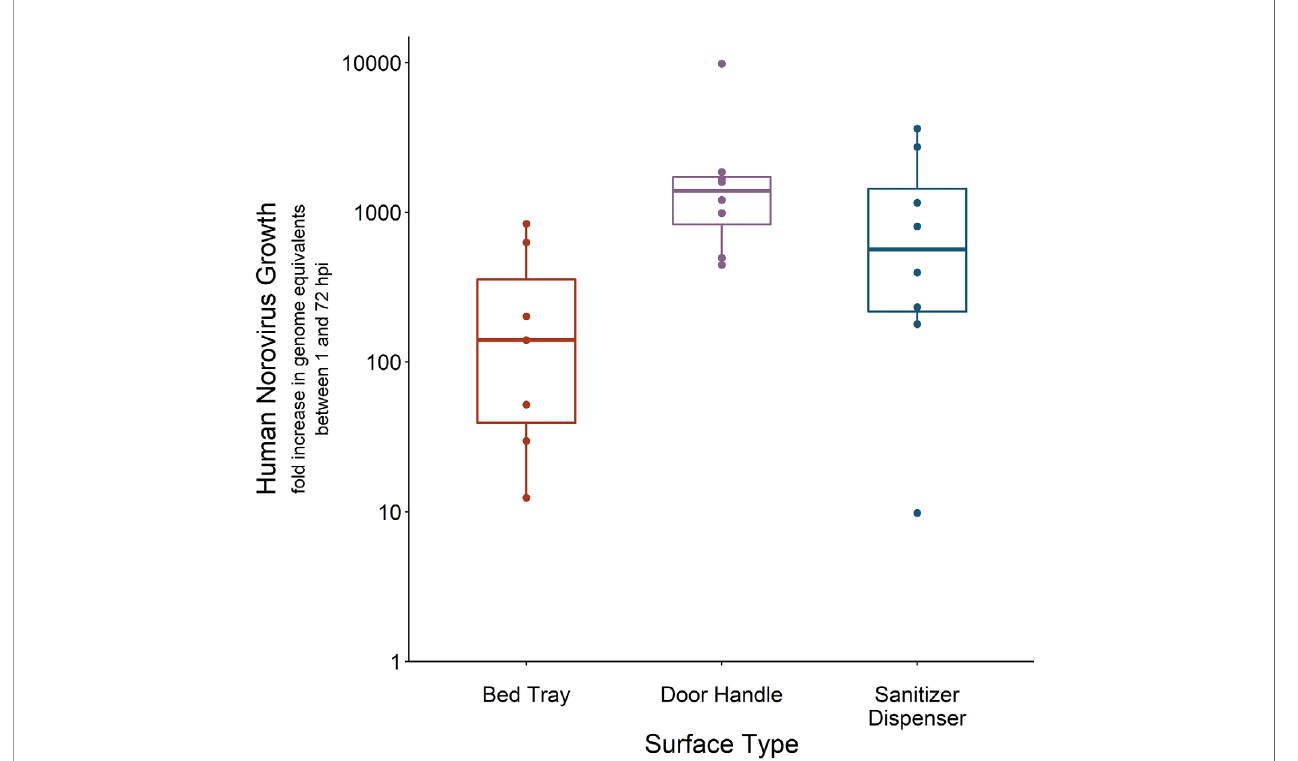
FIGURE 4 | Human norovirus (HuNoV) replication from swabs recovered off lab-inoculated fomites. Three fomites — a laminated fi berboard hospital bed tray (n = 7), a brushed stainless steel door handle (n = 8), and an acrylonitrile butadiene styrene (ABS) plastic sanitizer dispenser (n = 7) — were inoculated with 50 m l HuNoV stool suspension containing 10 6 or greater HuNoV genome equivalents (GE) per 3 cm 2 . Fomites were swabbed with macrofoam swabs pre-moistened in phosphate buffered saline plus 0.02% Tween80. Human intestinal enteroid (HIE) monolayers were infected with swab eluate and HuNoV replication is reported as the fold increase in HuNoV GE between 1 and 72 h post infection (hpi). Fold-increase of fi ve or lower was considered negative for infectious HuNoV; only swabs positive for infectious HuNoV are